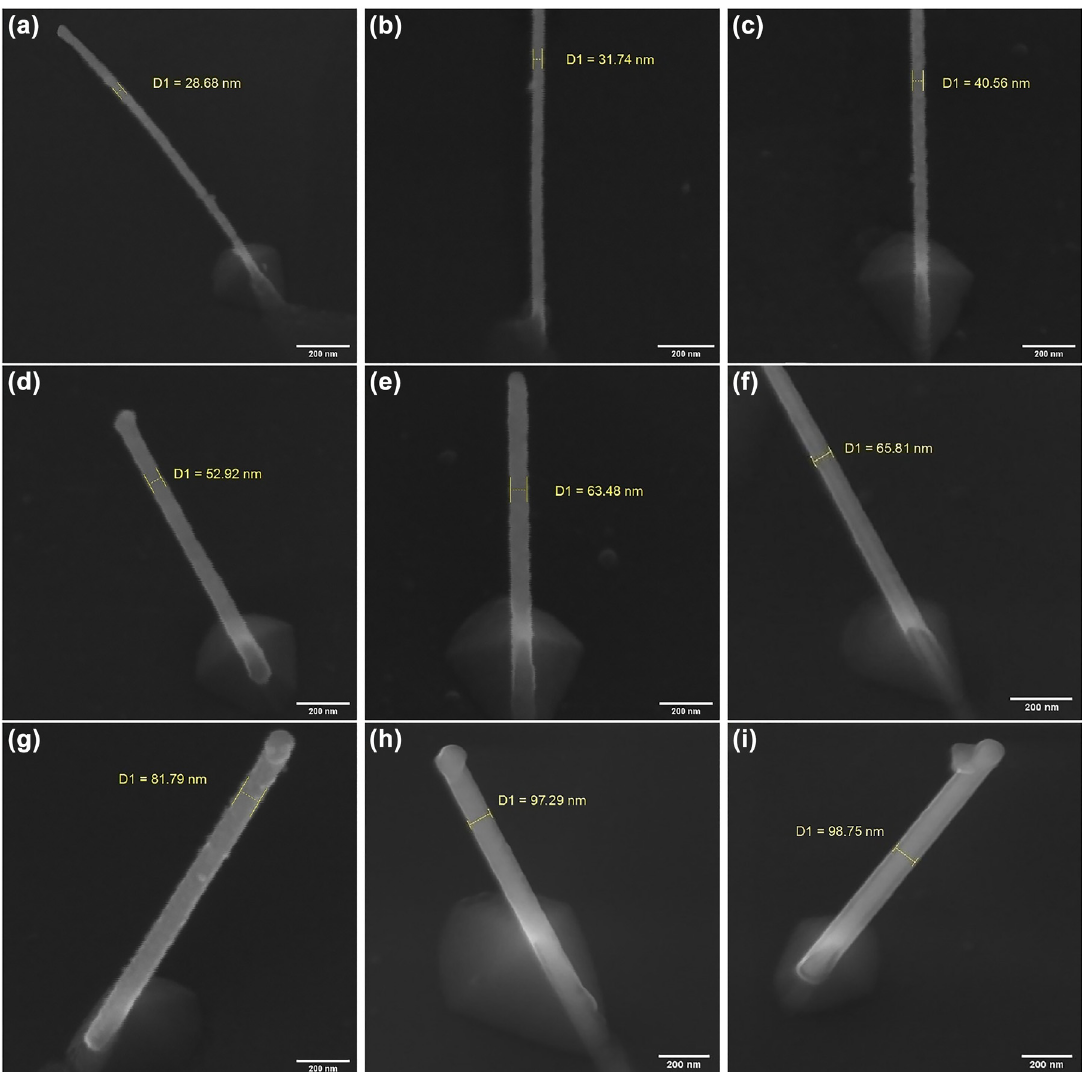
Figure 5: Localized ONF-CVD fabrication of CNT-tips. Typical examples of the grown individual free-standing well-oriented carbon nanotubes without bending/buckling at the tips apexes for the case of 5 nm (a–c), 10 nm (d–f), and 15 nm (g–i) initial catalyst deposition. The approximately measured diameter of each nanotube is shown in